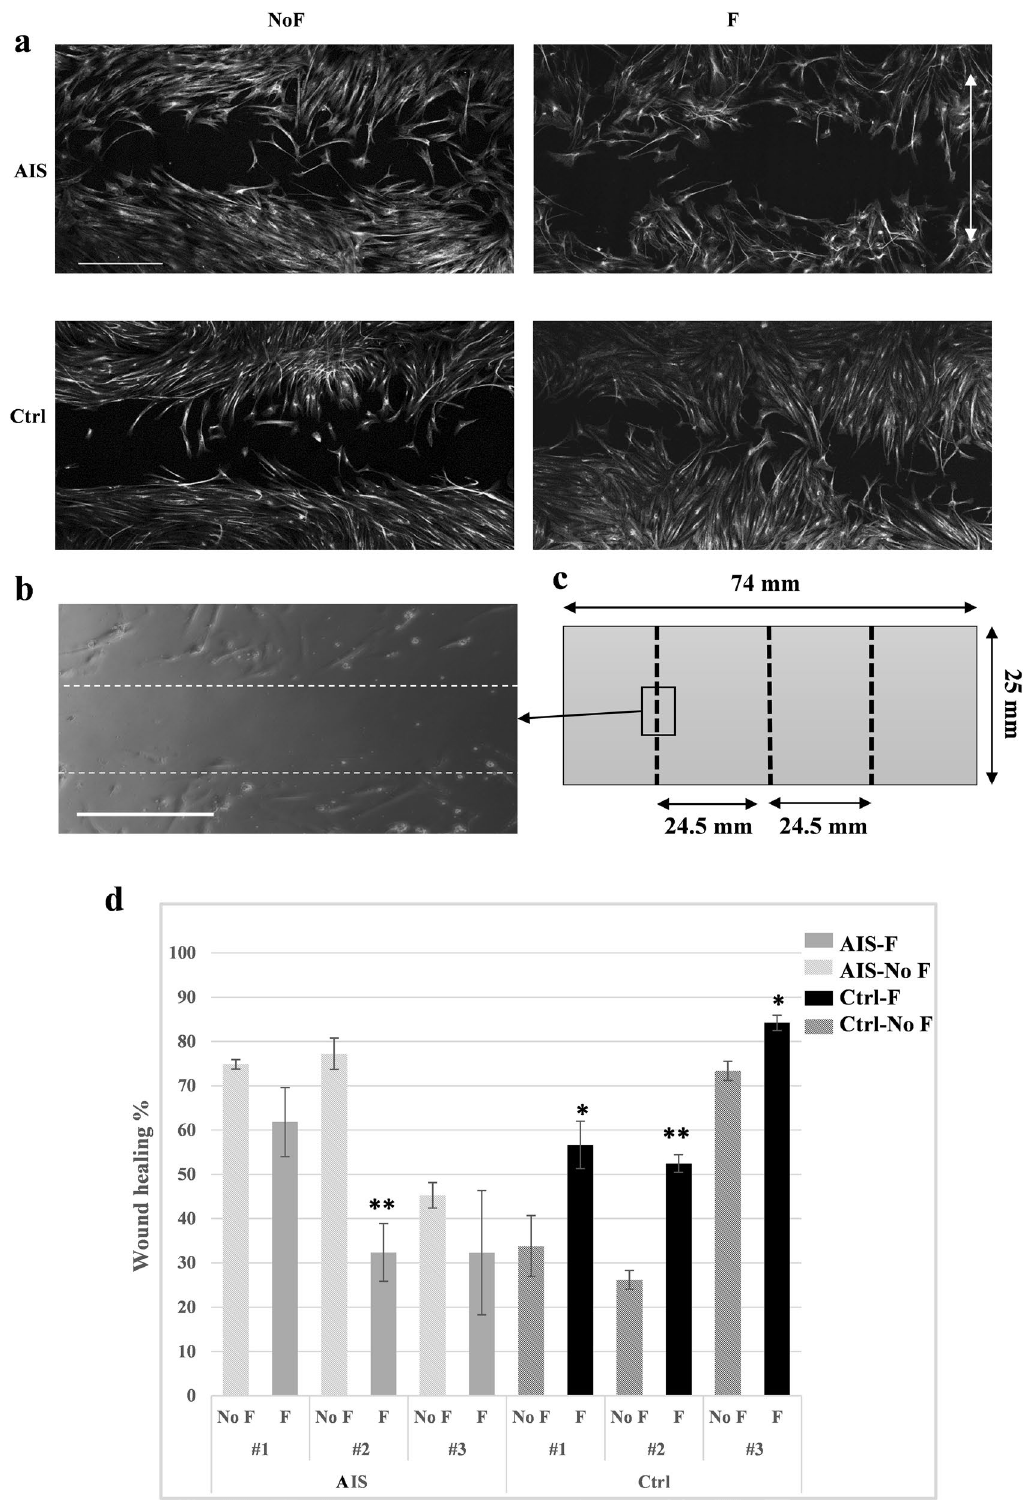
Figure 3. Fluid flow does not increase the rate of wound healing/cell migration in AIS cells. ( a ) Grayscale immunofluorescence micrographs (Objective 10×) of wounded monolayers of AIS and control primary osteoblast at T20h with (F) or without (NoF) flow application. Cells are stained for their nucleus and actin filaments. White scale bar, 500 µm. The double-headed arrow indicates the direction of flow. ( b ) An example of a T0 image that shows live cells immediately after applying the scratch (Objective 20×), the dotted white lines indicate the boundaries of the scratched line, Scale bar, 500 µm. ( c ) The schematic view of the one well chamber slide, dotted black lines show the three scratches and their positioning. We studied three scratched per sample, and three fields of views per scratch. The study was performed independently on cell samples from 4 control and 4 AIS donors (n = 4 per group). ( d ) Data represents the mean ± SEM of wound healing percentages for IS and control cells. Each no flow (NoF) condition sample was compared to their corresponding flow condition (F) using Student T-test using JMP-14. * p value < 0.05, ** p value <